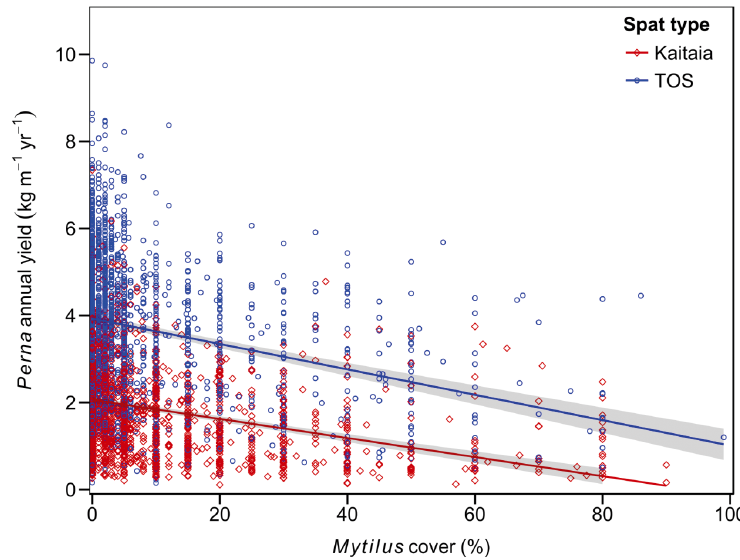
Fig. 4. Annualised yield of Perna canaliculus for crops outgrown from 2 spat types (Kaitaia and top-of-the-South; TOS), in relation to Mytilus gallo- provincialis cover. Linear regression lines are bounded with 95% confi- dence inter-vals (grey shading) predicted from the generalised least squares